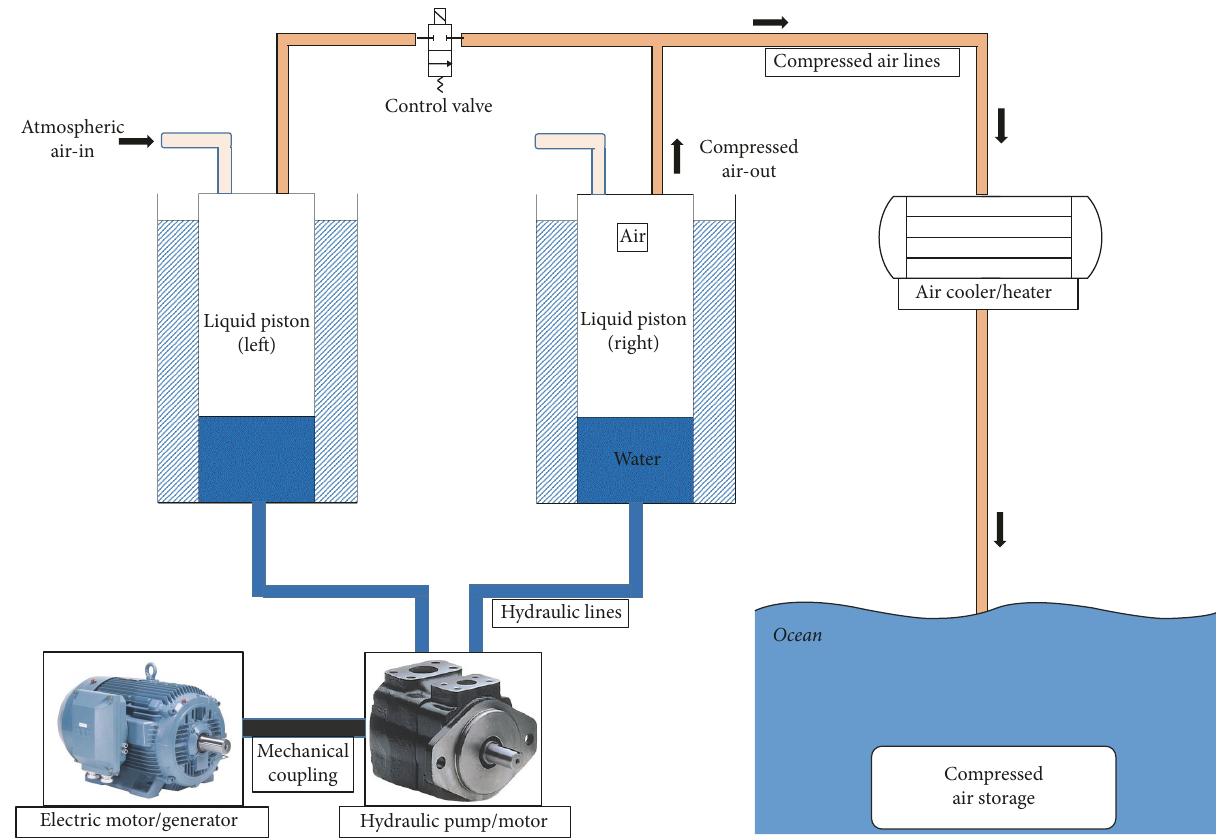
Figure 4: Schematic of a liquid piston based isothermal OCAES